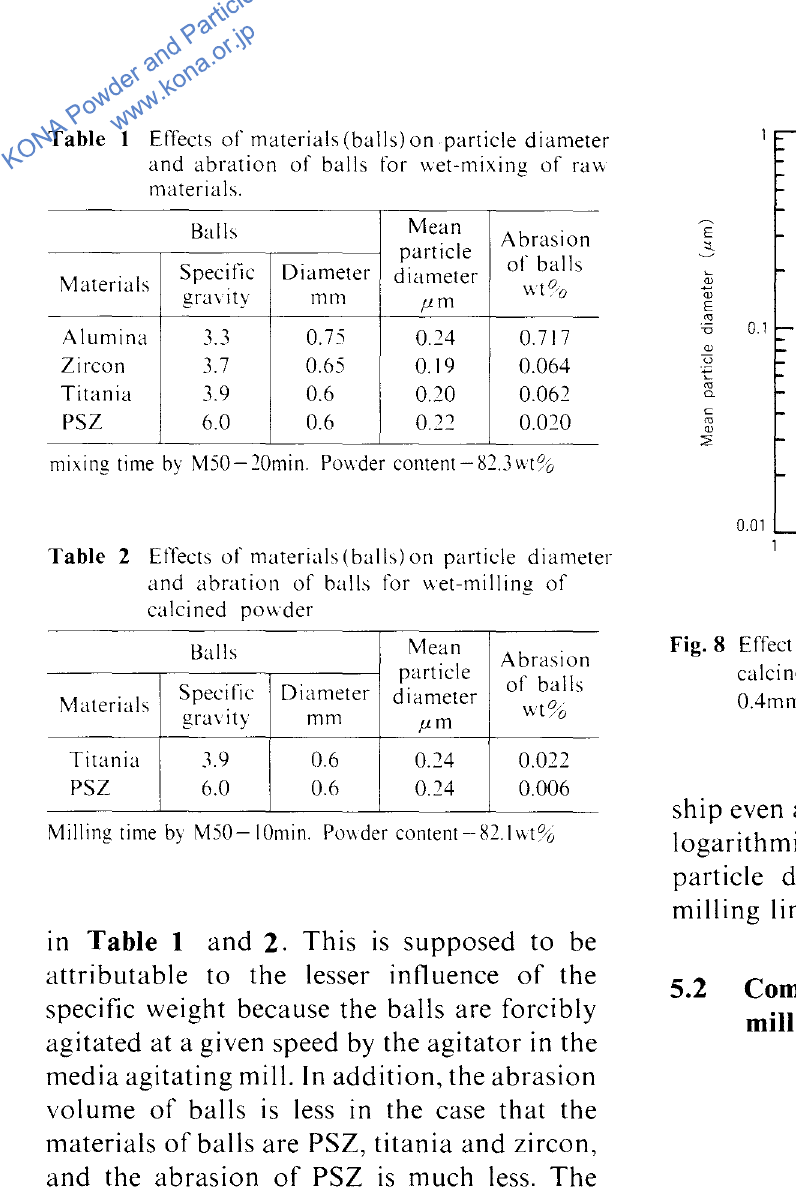
Table 1 Effects of materials (balls) on particle diameter and abration of balls for wet-mixing of rav. materials.